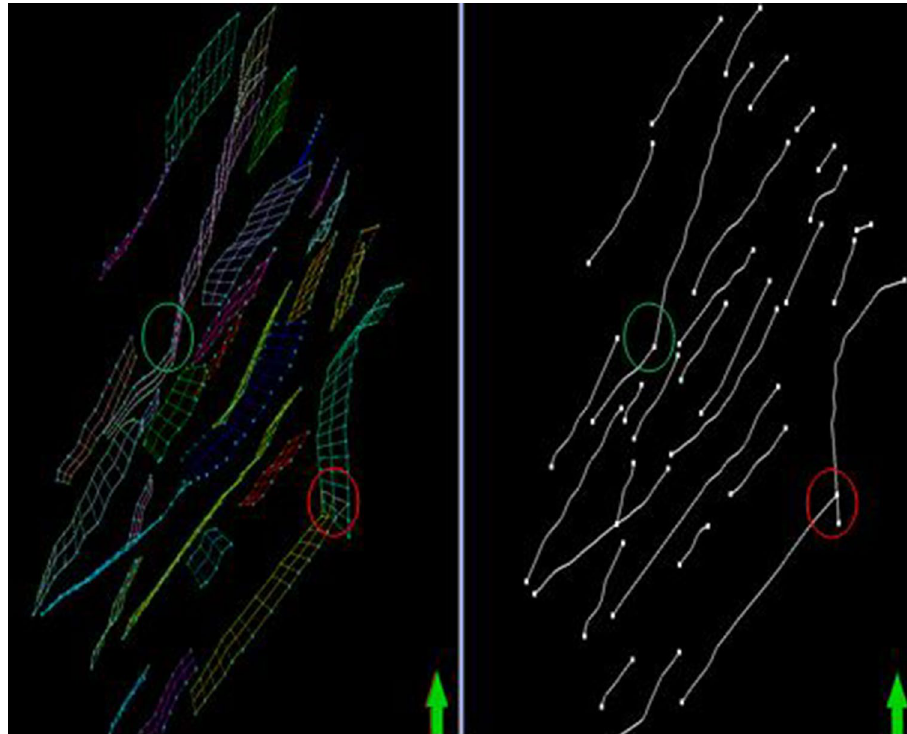
Fig. 1 Fault pattern of the